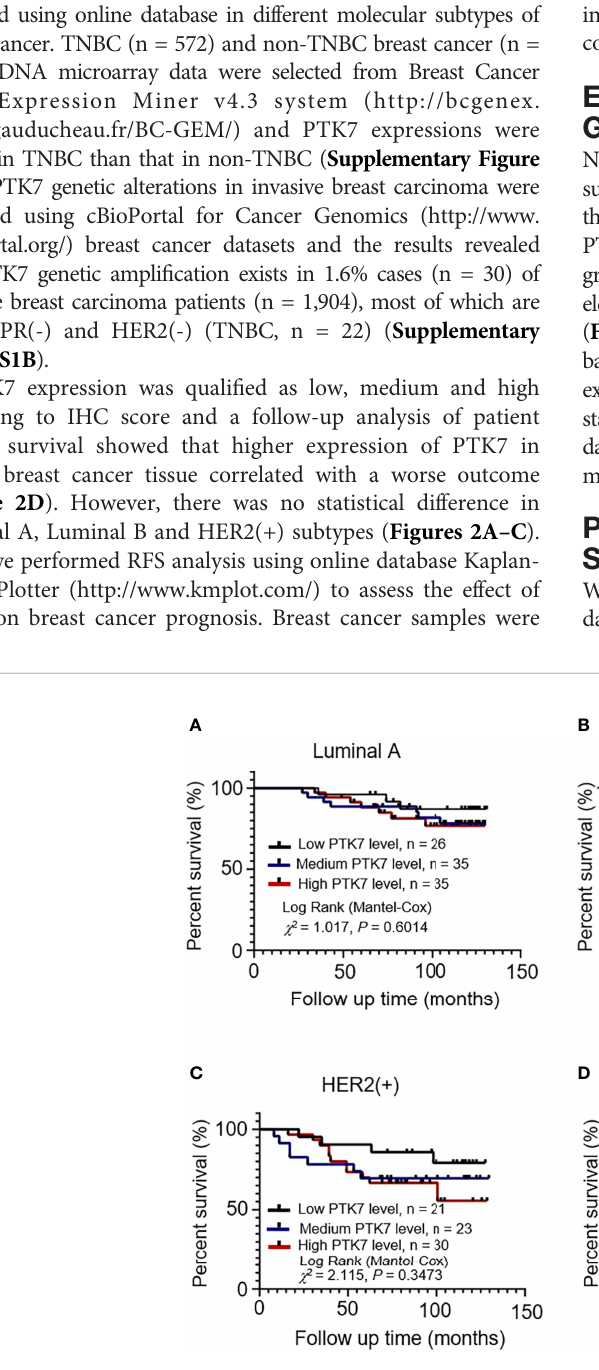
FIGURE 2 | PTK7 upregulation is associated with poor patient survival in TNBC. Breast cancer samples were divided into groups based on PTK7 expression [low expression (IHC score 0~4), medium expression (IHC score 4~8) and high expression (IHC score 8~12)]. Kaplan-Meier overall survival curve analysis and two-sided log-rank tests were performed in Luminal A (A) , Luminal B (B) , HER2(+) (C) and TNBC (D) breast cancer molecular subtypes, respectively. Marks on graph lines represent censored